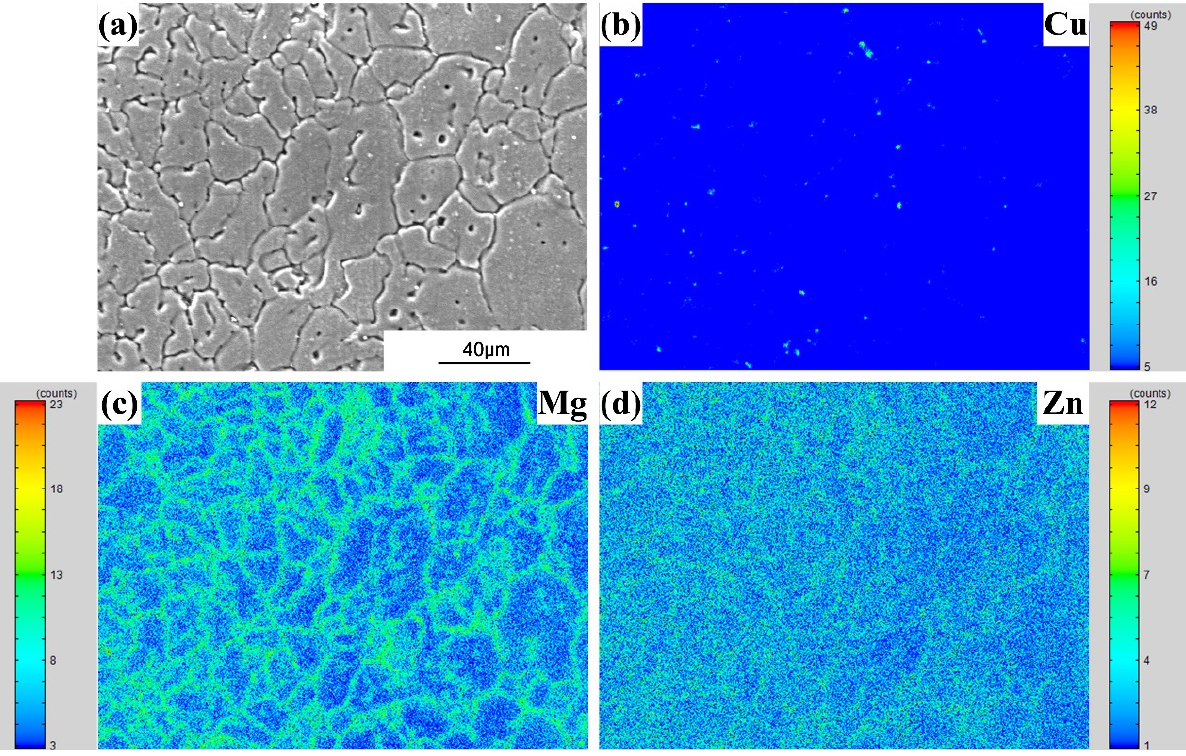
Figure 11. The EPMA mapping results (the AA7075/Al-Cu 2.3 -Mg 2.3 -Zn 6.6 weld): ( a ) Secondary electronic image; ( b ) Cu distribution; ( c ) Mg distribution; ( d ) Si distribution.